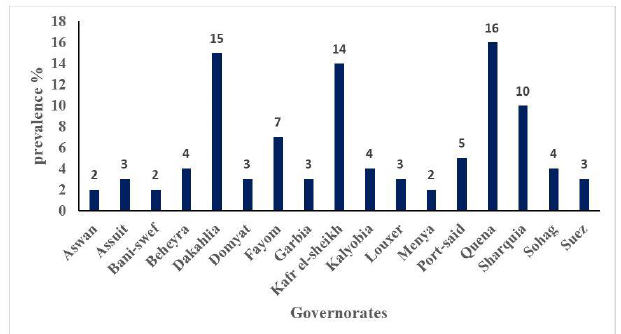
Fig. 2: Prevalence % of LSD in 17 governorates during 2017 (n = 95).